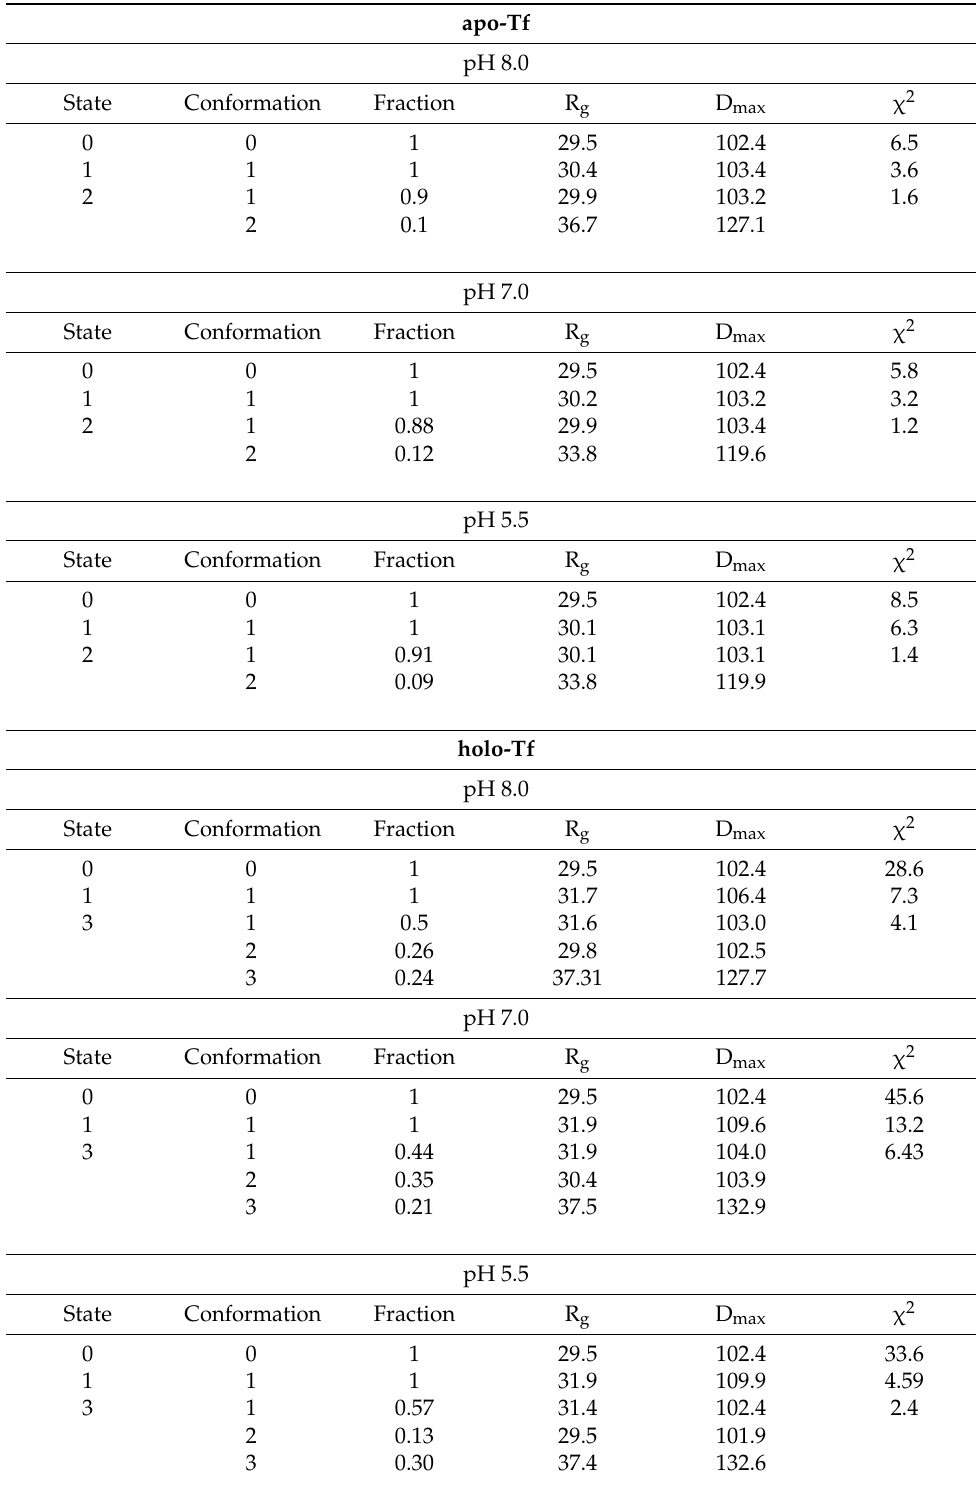
Table 3. Experimental and calculated data for apo- and holo-Tf at three different pH